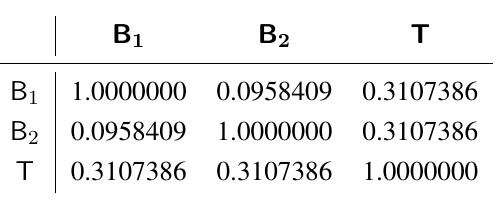
Table 7. Correlation matrix of dataset of dataset DFQR